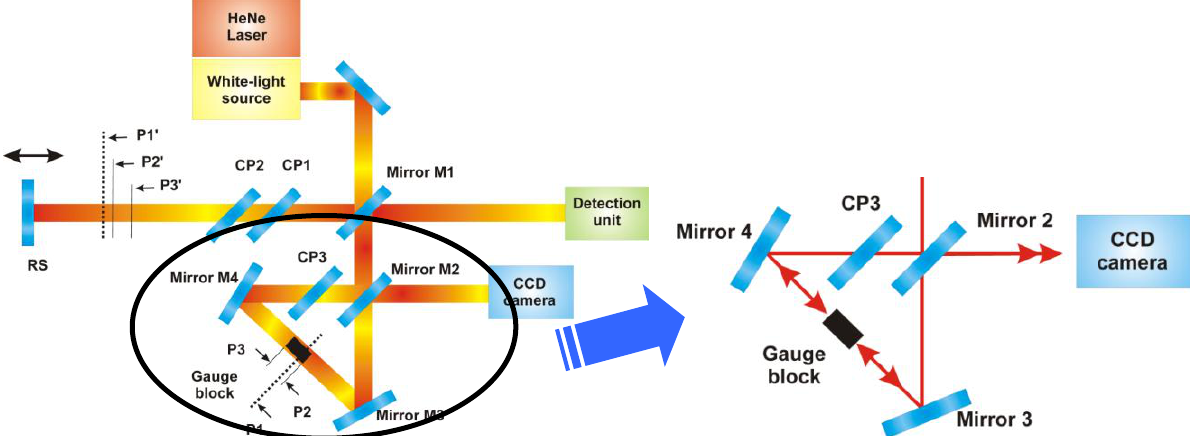
Figure 2. New version of the system for gauge block calibration (left hand side) and a simplified detail view of the dowel interferometer with a gauge block (without the part of the beam going alongside the gauge blosk) and CCD camera used for the gauge block angular alignment. CP1, CP2 and CP3 are compensating plates and RS is a reference